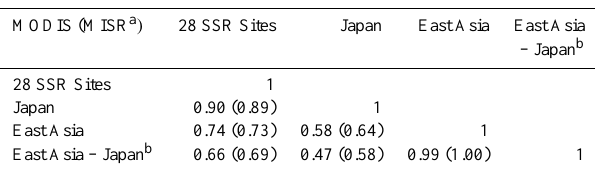
Table 4. Correlation coefficients ( R ) between the data sets in Fig.